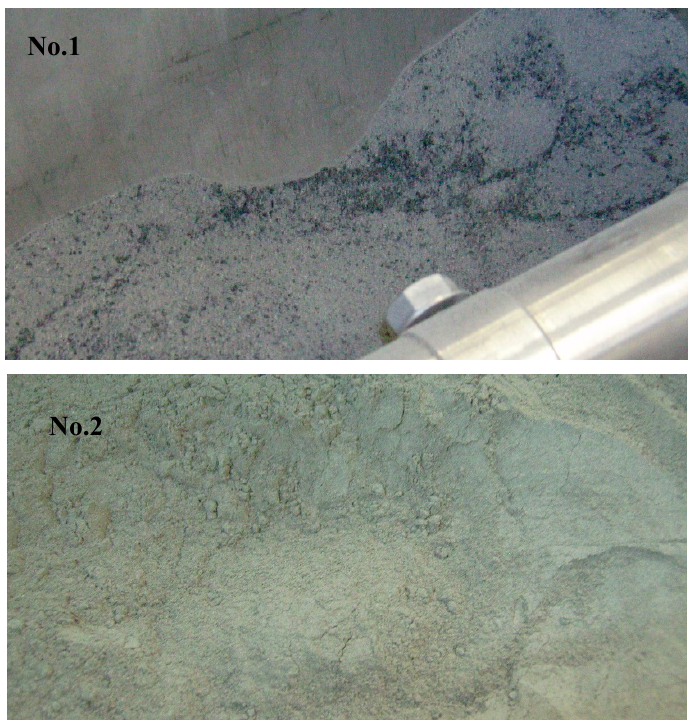
Figure 4. Photograph of lignite fly ash samples, no. 1 and 2 before the